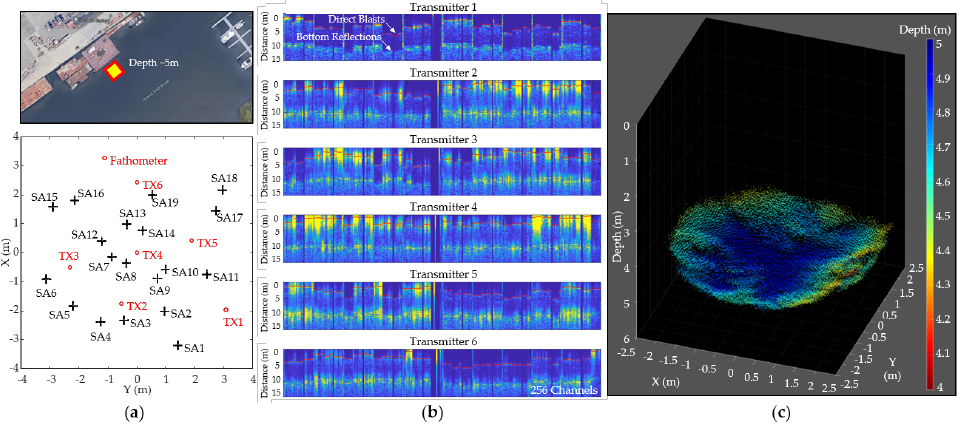
Figure 12. Initial pier-side test results of the oceangoing sparse-aperture sonar. The array layout and range profiles from all transmitter–receiver pairs are shown in ( a , b ), respectively. The reconstruction point cloud of the pier bottom is shown in ( c